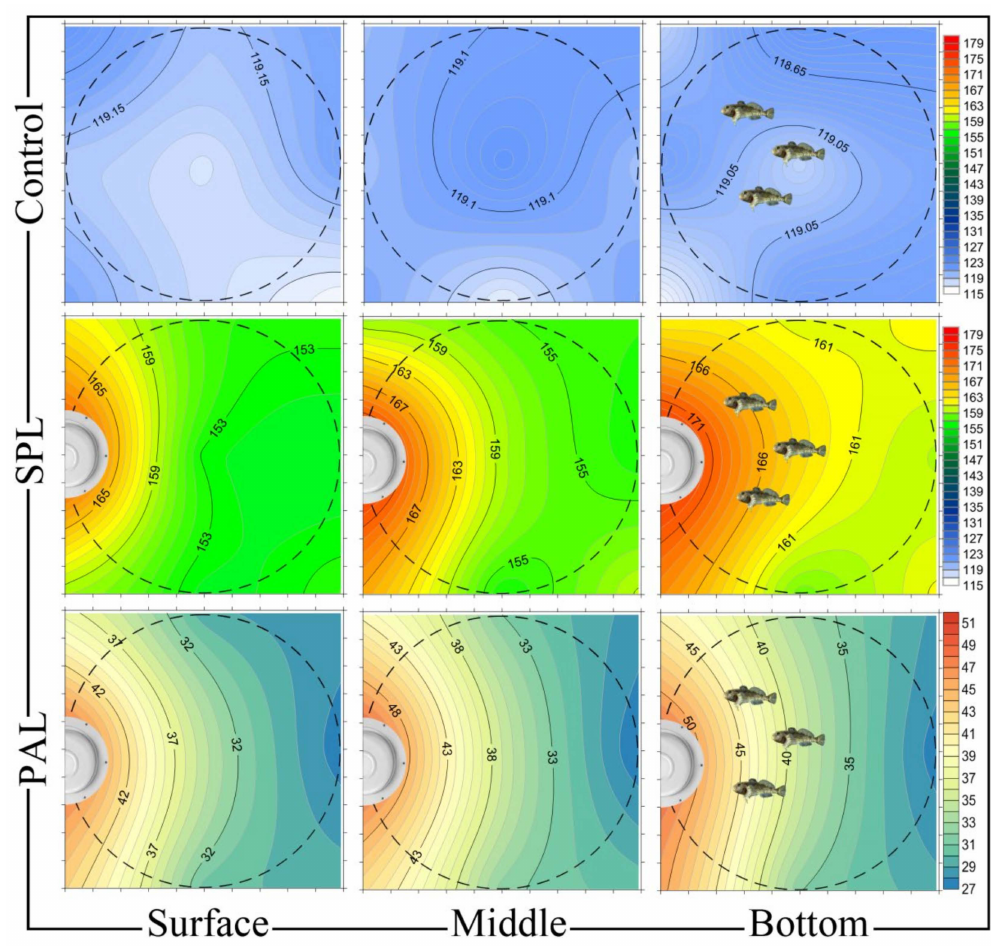
Figure 1. Sound pressure levels (SPL, dB re: 1 µ Pa) and the particle acceleration levels (PAL, dB re: 1 µ m/s 2 ) in the x , y , and z directions at the surface, mid-depth, and tank bottom. The control tank was used for fish without anthropogenic impact, and the experimental one for fish with noise exposure (HIREC